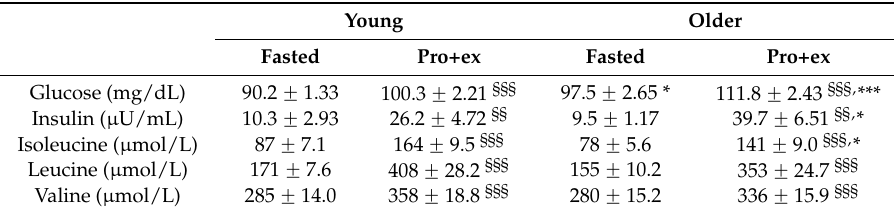
Table 3. Plasma glucose, insulin, and branched-chain amino acids concentrations.